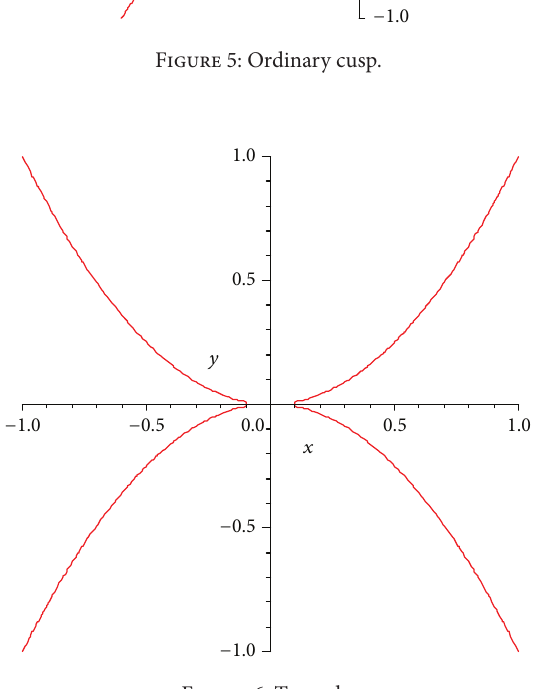
Figure 6: Tacnode.